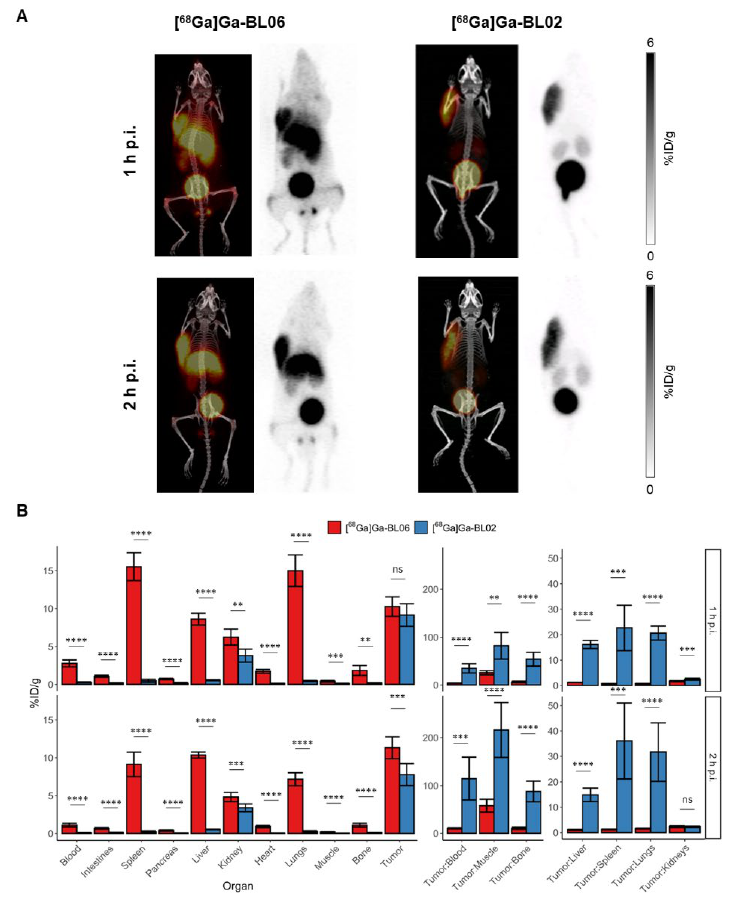
Figure 2. ( A ) Maximum intensity projections for PET/CT and PET alone at 1 and 2 h p.i. of [ 68 Ga]Ga- BL06 and [ 68 Ga]Ga-BL02. Scales of the PET images of [ 68 Ga]Ga-BL02 and [ 68 Ga]Ga-BL06 are 0–6 %ID/g. ( B ) Ex vivo biodistribution data of [ 68 Ga]Ga-BL06 in comparison to that of [ 68 Ga]Ga-BL02 in Daudi xenograft-bearing mice at 1 and 2 h p.i. ( p < 0.01 = **, p < 0.001 = ***, p < 0.0001 = ****, ns = not significant).